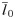
The influence of infant mortality on the relationship between l¯0 and e0 (in years).Shown are data points calculated from mortality trajectories where a0, a1, and c > 0, and b0 = b1 = 0. (a) The effect of infant mortality. (b) The effect of age-independent mortality.